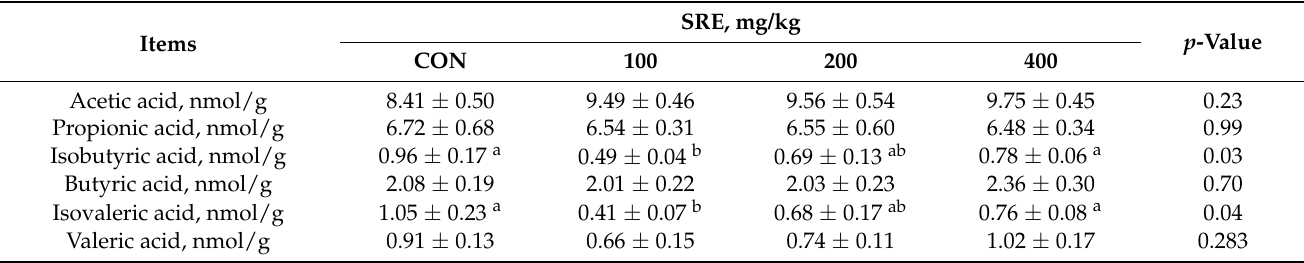
Table 7. Effects of supplementation with stevia residue extract in the diet on the content of short-chain fatty acids in the colonic contents of weaned piglets on day 42 of the trial (a) .